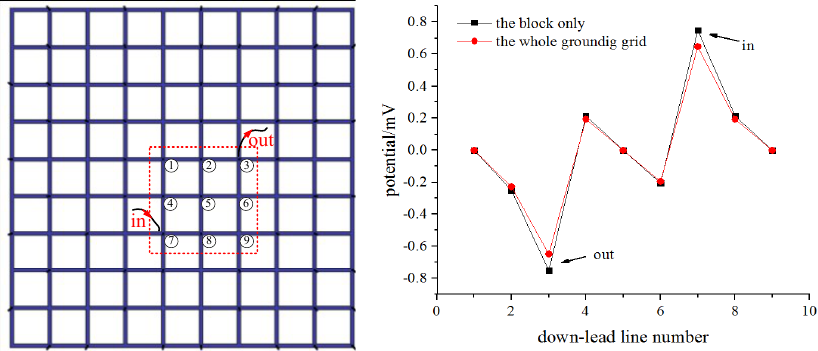
Figure 6. The potentials calculation on the block only and the whole grounding grid. ( a ) The grounding grid model; ( b ) The calculation results.